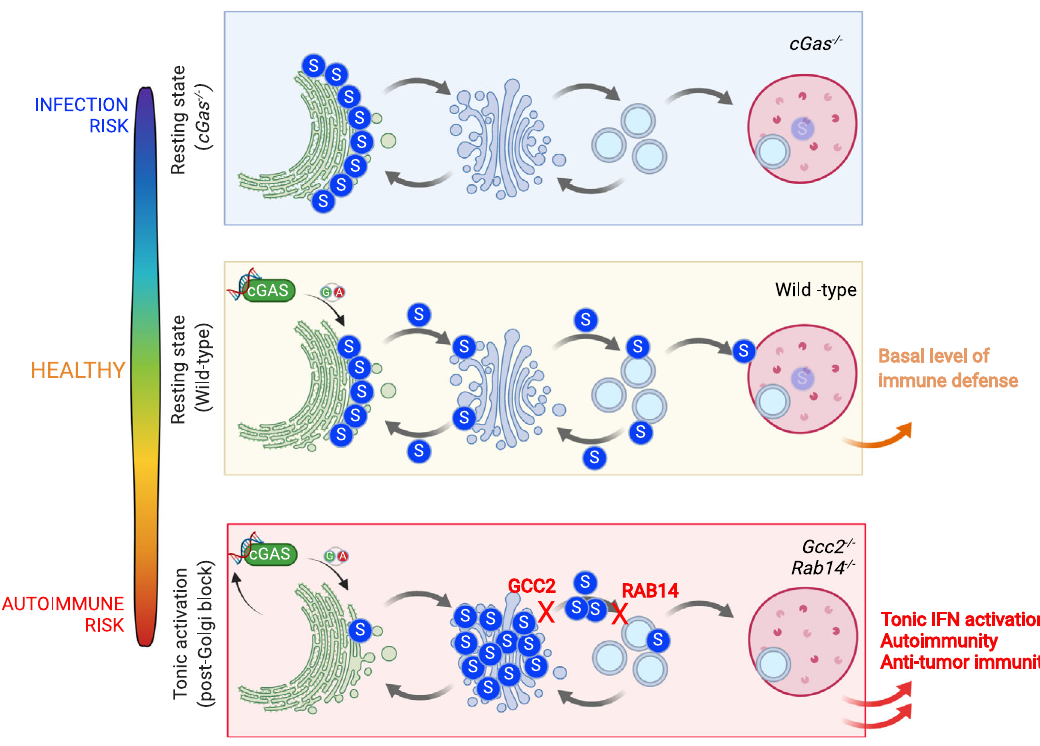
Fig. 9 | An overall model. Homeostatic cGAS activity drives STING traf fi cking that supports the basal level of immune defense and maintains a healthy state. cGas − / − cells and mice have lowered basal immune defense, leading to infection